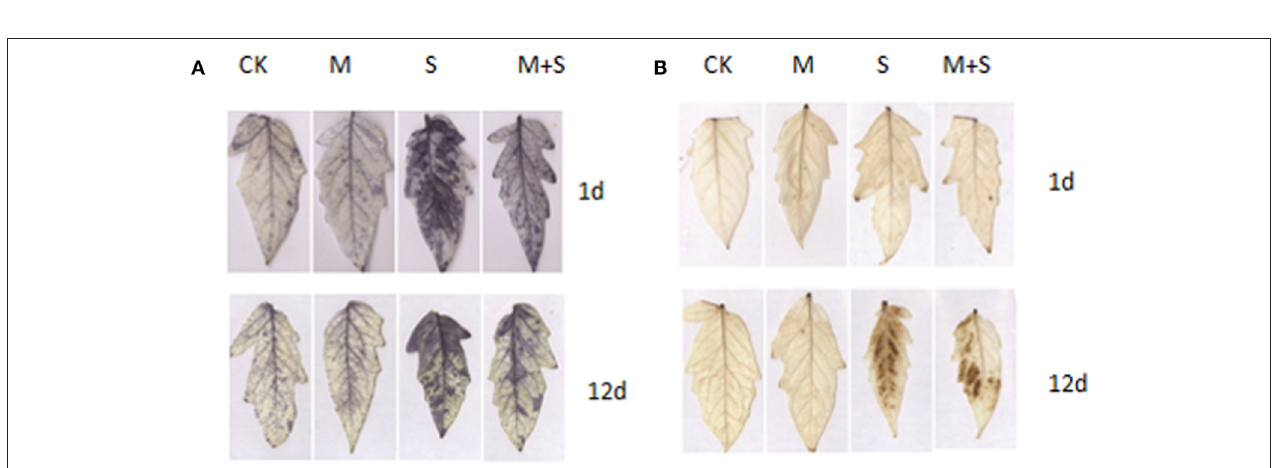
FIGURE 3 | qRT-PCR analyses of expressions of genes that regulate redox. Results were analyzed from data for 12-day, salt-stressed leaves. CK, control; M, 150 µ M melatonin; S, 150 mM NaCl; M + S, 150 µ M melatonin with 150 mM NaCl. qRT-PCR analyses of expressions of TRX f (thioredoxin f), TRX m1/4 (thioredoxin m1/4) and TRX m (thioredoxin m2). Letters indicate significant differences at P < 0.05 according to Duncan’s multiple range tests.